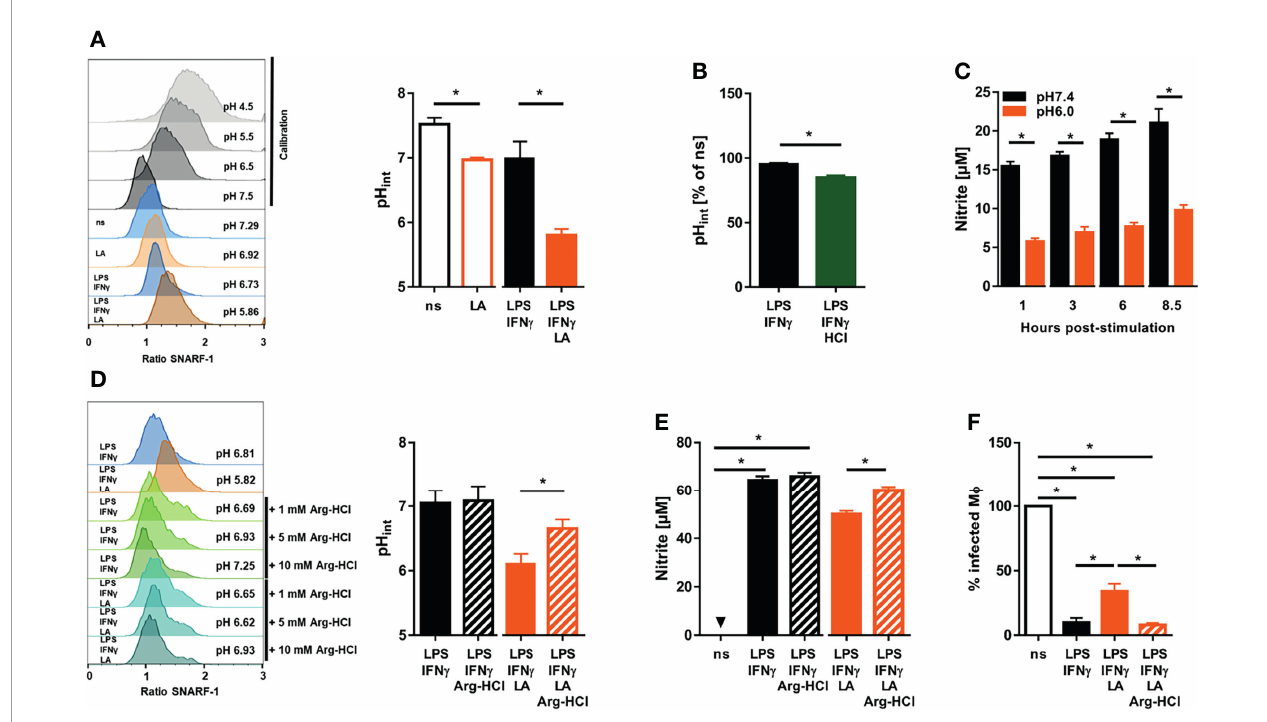
FIGURE 5 | Exposure to lactic acid triggers low intracellular pH levels which directly impair NOS2 enzyme activity in LPS/IFN- g coactivated macrophages (A) BMDM were costimulated with LPS (10 ng/mL)/IFN- g (20 ng/mL) or left unstimulated (ns) for 24 h. Where indicated, cells were treated with 10 mM lactic acid (LA). Determination of intracellular pH. Left panel: representative histograms out of four similar independent experiments upon exposure to calibration buffers (in grey), unstimulated (ns), 10 mM lactic acid (LA), and LPS/IFN- g ± LA treated BMDM. Right panel: intracellular pH (mean + SEM, n = 4 samples from four independent experiments; * p < 0.05, Mann-Whitney test. (B) BMDM were costimulated with LPS (10 ng/mL)/IFN- g (20 ng/mL) for 24 h. Where indicated, cells were treated with additional 10 mM hydrochloric acid (HCl). Determination of intracellular pH in percent of unstimulated (ns) cells (mean + SEM, n = 4 samples from four